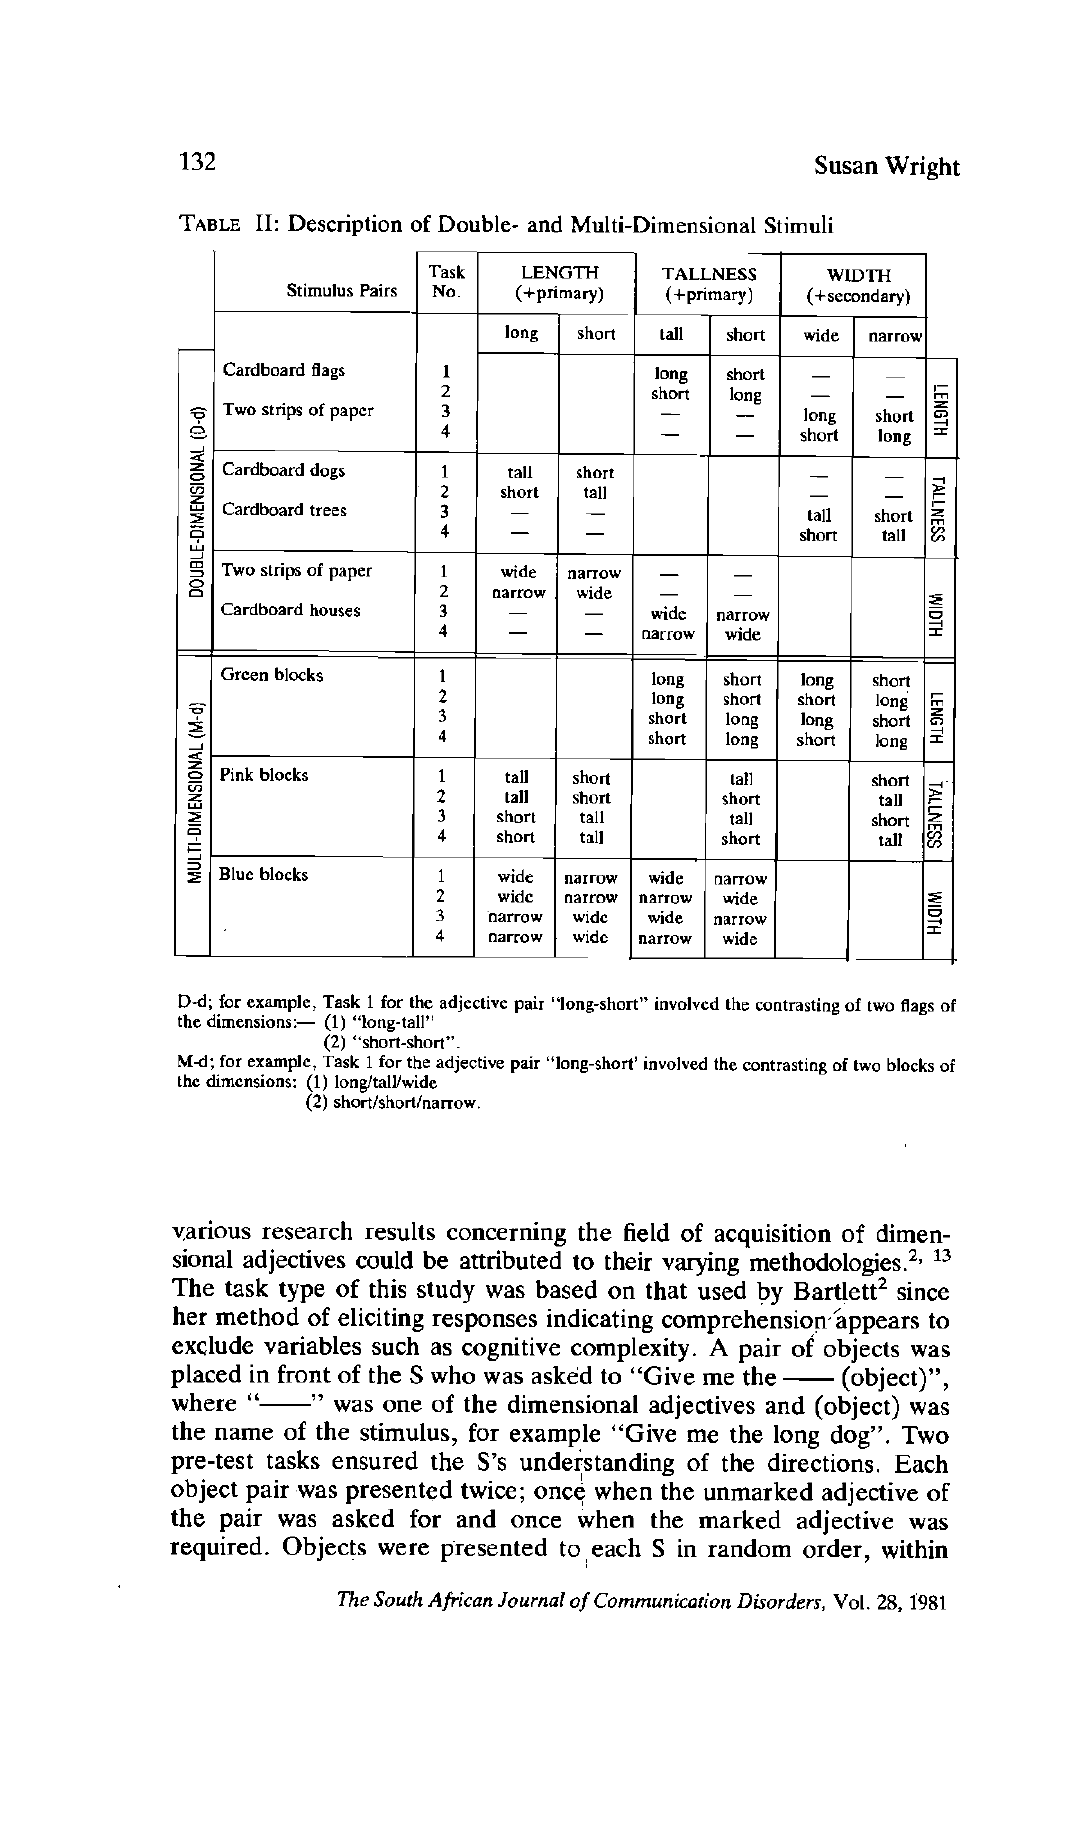
TABLE II: Description of Double- and Multi-Dimensional Stimuli Stimulus Pairs Cardboard flags Two strips of paper